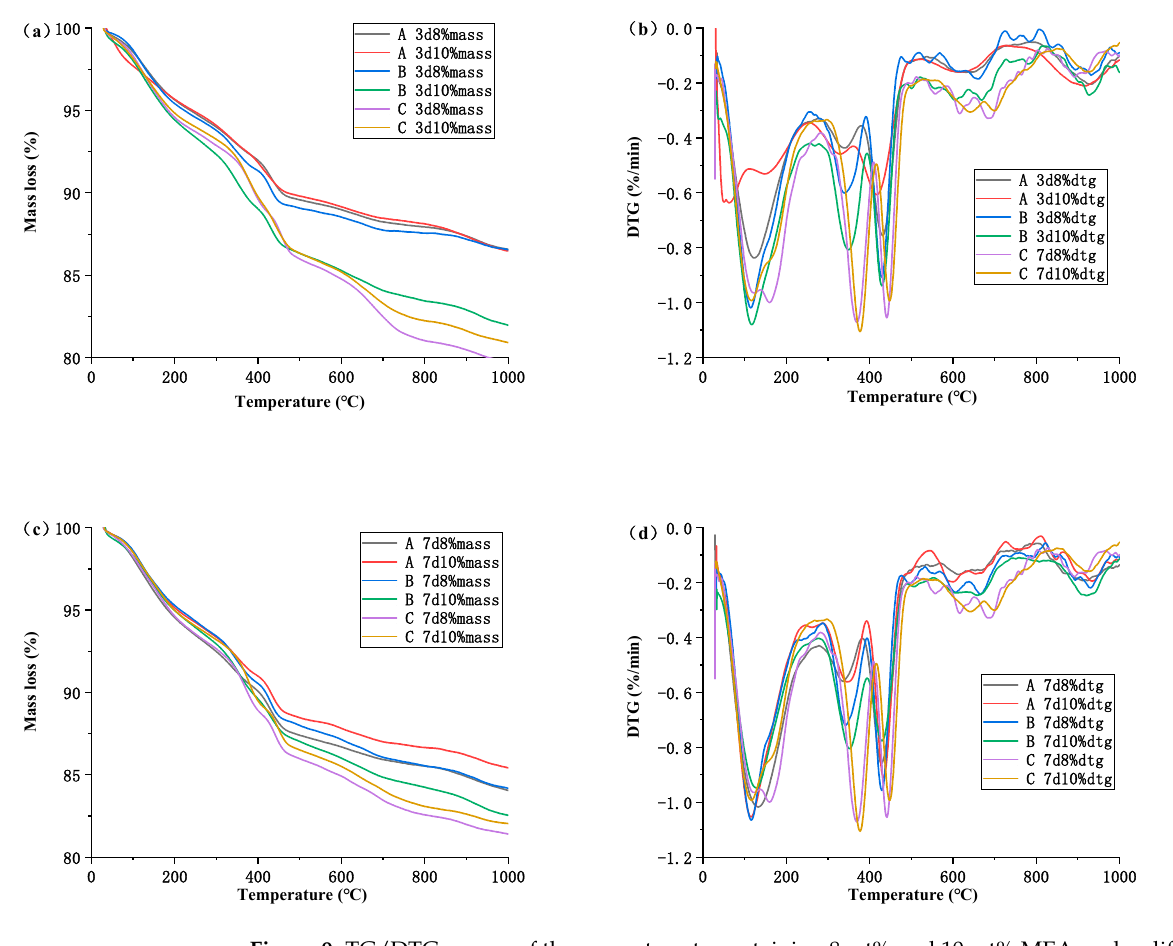
Figure 9. TG/DTG curves of the cement paste containing 8 wt% and 10 wt% MEA under different temperatures at 3 d and 7 d. ( a ) TG curves, at 3 d; ( b ) DTG curves, at 3 d; ( c ) TG curves, at 7 d; ( d ) DTG curves, at 7 d.